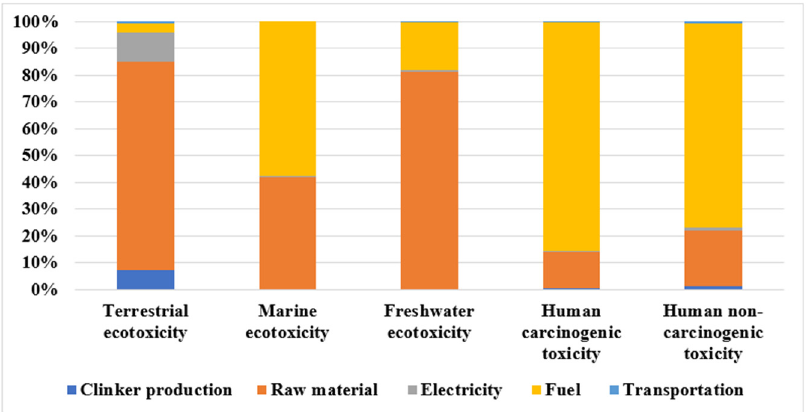
Figure 4. Contribution of each production stage to toxicity.